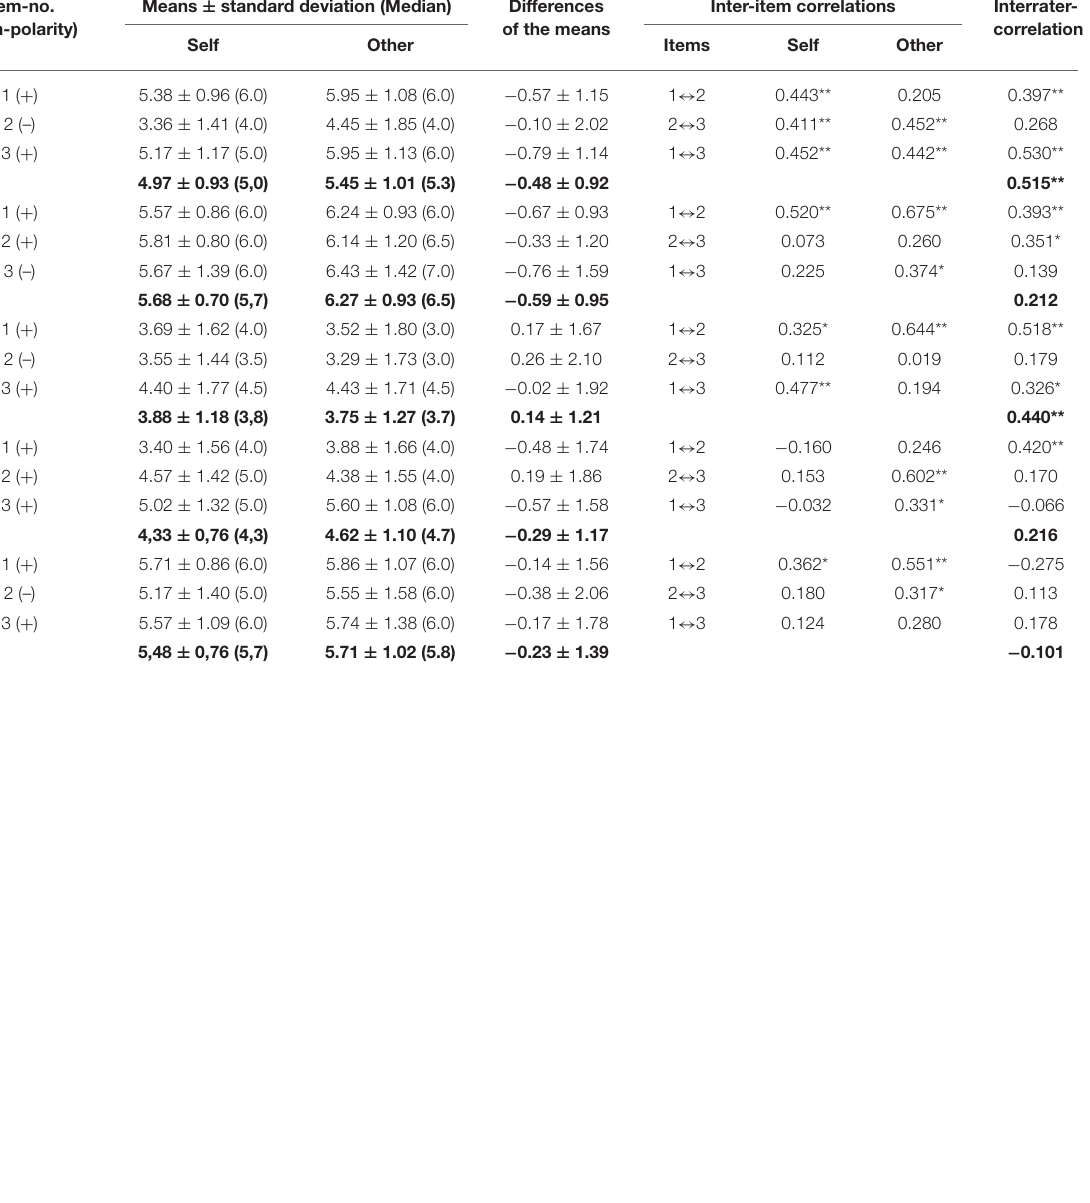
Means ± standard deviation (Median) Differences Inter-item correlations Interrater- (Item-polarity) of the means correlation Self Other Items Self